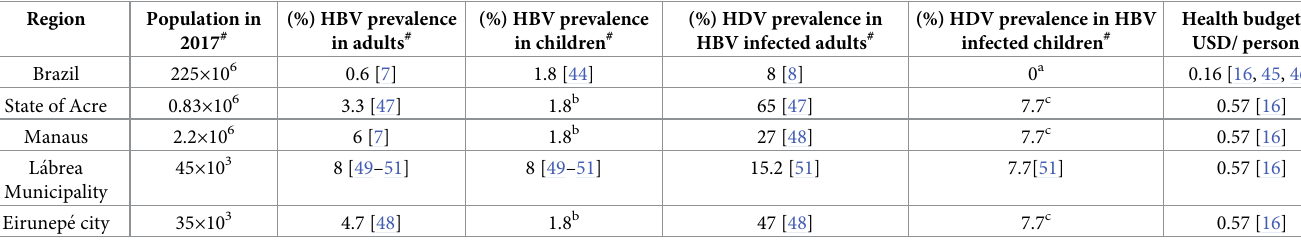
DNA levels in individuals resulting from treatment [15]. Furthermore, infected individuals who fail treatment are assumed to transmit infections at the same rate as diagnosed infections without treatment. The awareness programs promoting safer sex and use of condoms are assumed to induce behavioral changes in the population leading to a reduction in the horizon- tal transmission rate of both HBV and HDV.